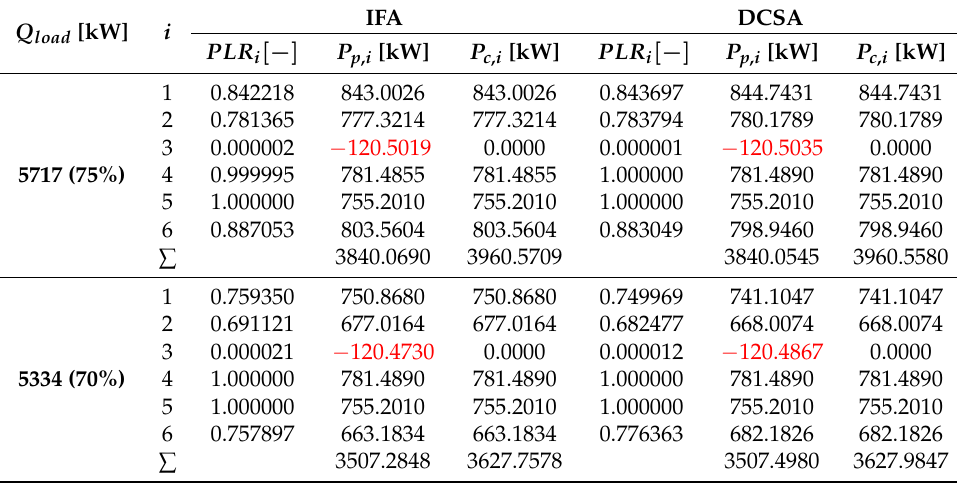
Table 2. Published chillers’ power consumptions and the corresponding corrected